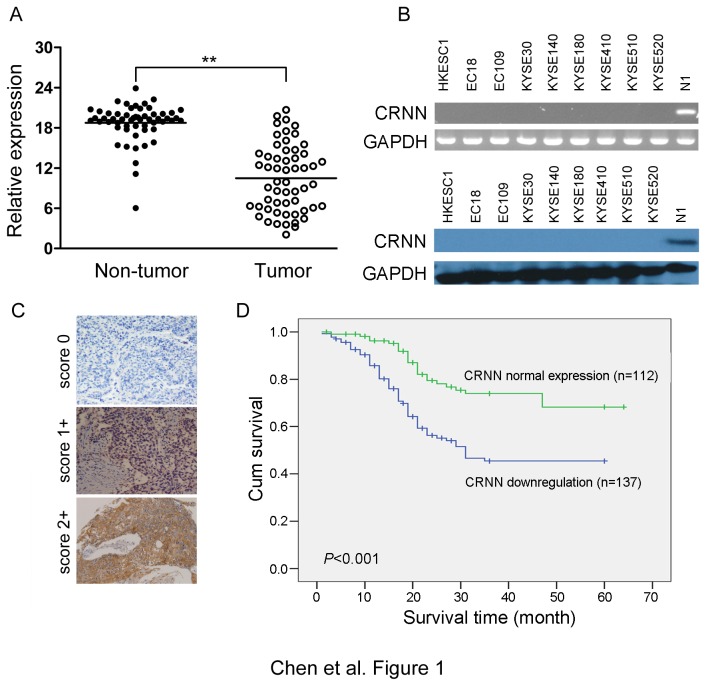
Downregulation of CRNN in ESCC.(A) qRT-PCR was used to compare CRNN mRNA levels between tumor and corresponding non-tumor tissues in 56 ESCC cases. **, P<0.01. (B) Absent expression of CRNN could be observed in all tested ESCC cell lines in both mRNA level (upper panel) and protein level (lower panel) detected by RT-PCR and western blot analysis, respectively. GAPDH was used as a loading control. N1, pool total RNA or protein from 5 non-tumor esophageal tissue specimens. (C) Representatives of immunostaining with anit-CRNN antibody in ESCC cases. Positive staining (brown) was detected in non-tumor esophageal epithelial cells but not in tumor cells. The slide was counterstained with hematoxylin. Original magnification, 200×magnification. (D) Kaplan-Meier analysis shows that downregulation of CRNN was significantly associated with poorer overall survival in 249 ESCC cases (P<0.001, Log-rank test).